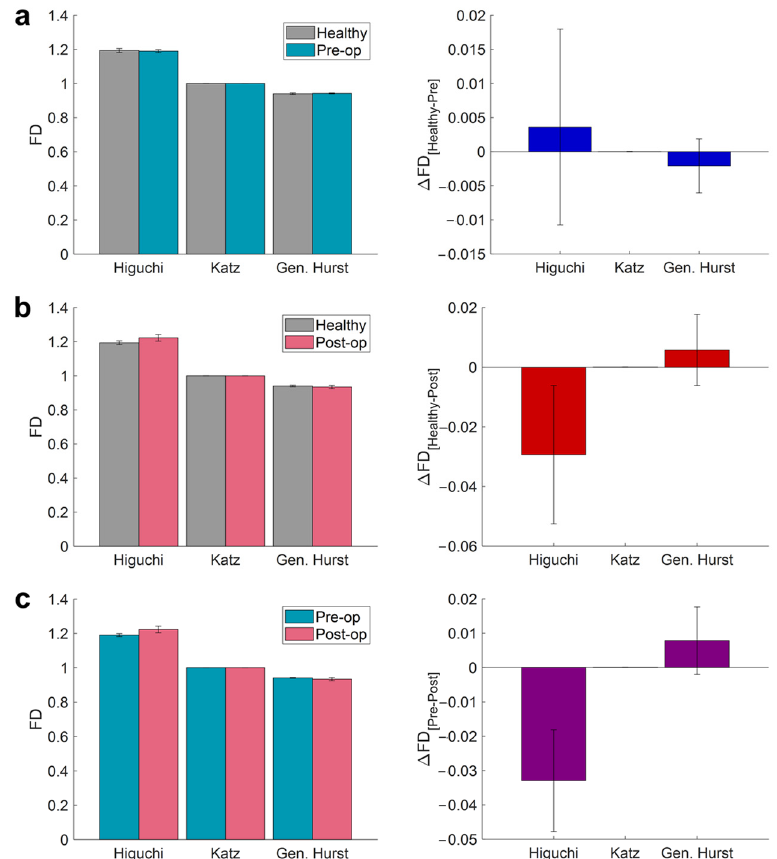
Figure 5. Average values of Higuchi FD, Katz FD, and generalized Hurst exponent (left panel) along with the difference in FD values (right panel) obtained from ELE-front measures for ( a ) healthy and pre-op ( p -value Higuchi = 0.710; p -value Katz = 0.620; p -value Hurst = 0.535), ( b ) healthy and post-op ( p -value Higuchi = 0.007; p -value Katz = 0.017; p -value Hurst = 0.383), and ( c ) pre-op and post-op ( p -value Higuchi = 0.018; p -value Katz = 0.028; p -value Hurst = 0.091) conditions. Table 5. p -values for the comparison of corneal elevation-derived FDs of the posterior surface (ELE-back) obtained from Pentacam. Subjects Pre-op Post-op Higuchi fractal dimension Healthy 0.535